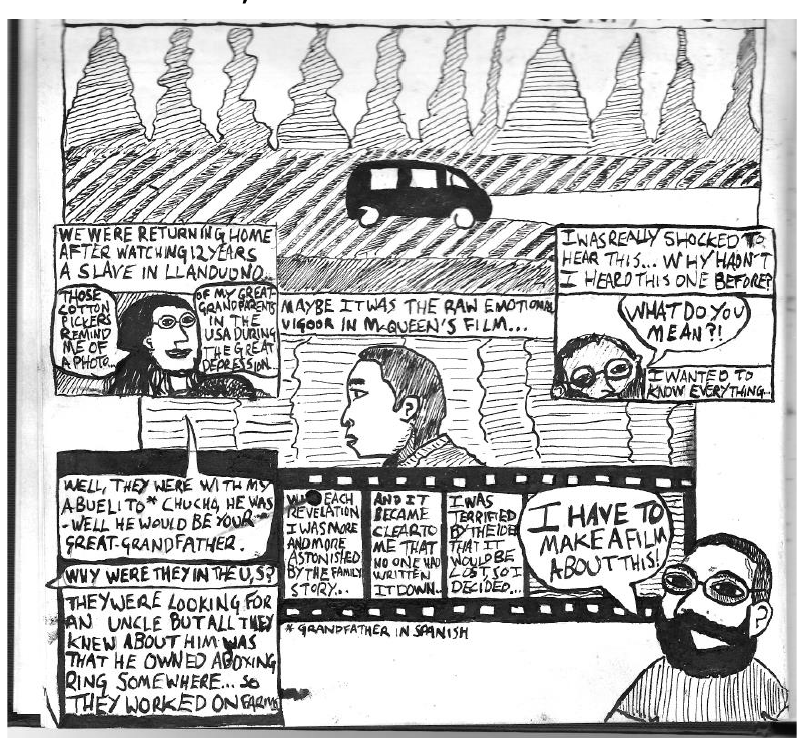
Figure 2: First comic I drew about the project, containing a summary of its genealogy . Courtesy: José Sherwood González,